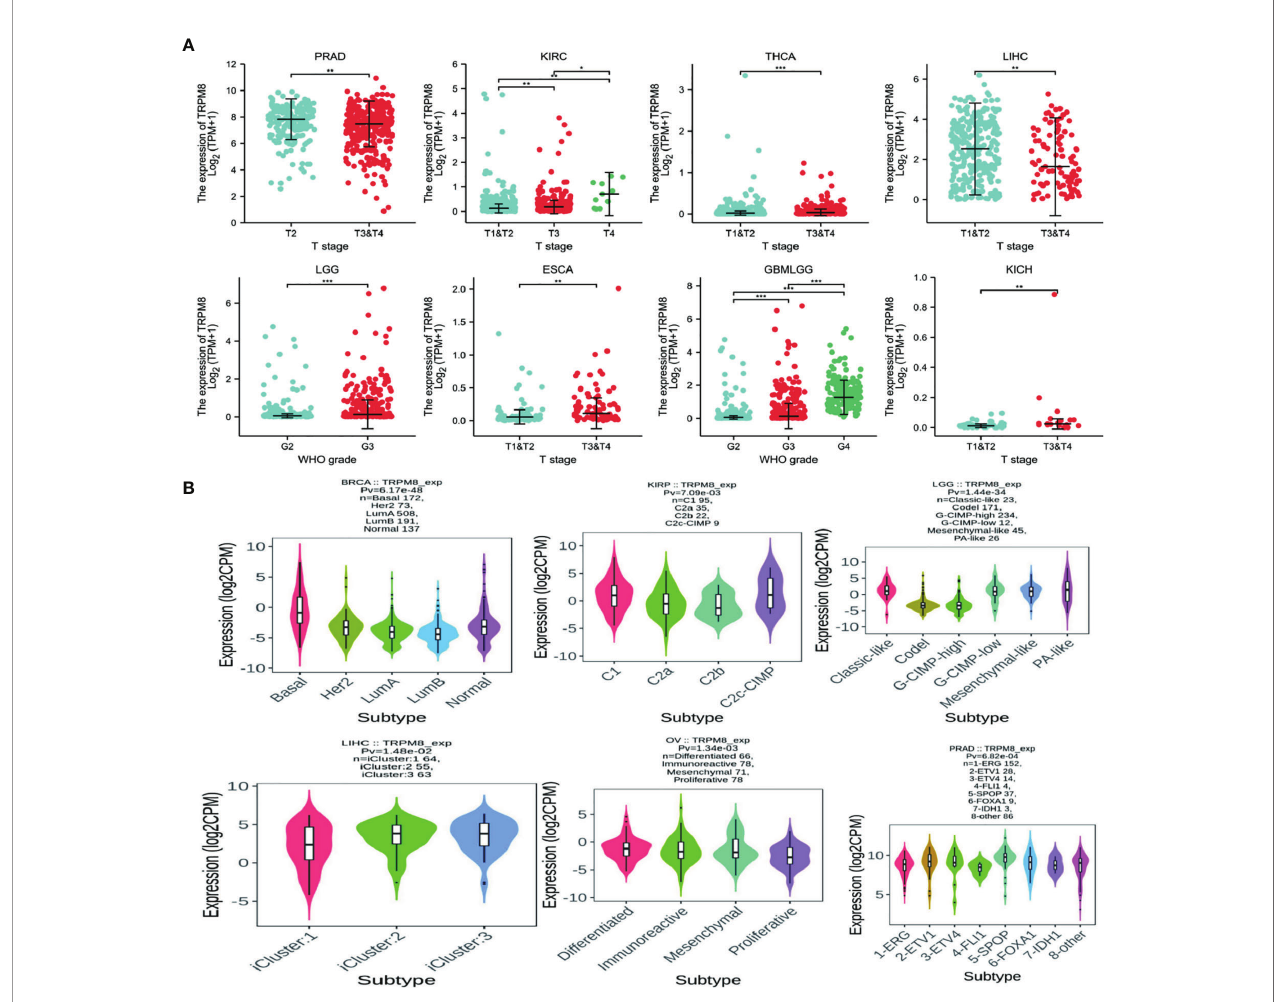
FIGURE 2 | TRPM8 mRNA levels in different tumor types. (A) TRPM8 in relation to clinical stage, from TCGA,*P < 0.05, **P < 0.01, and ***P < 0.001. (B) TRPM8 in relation to molecular subtype, from